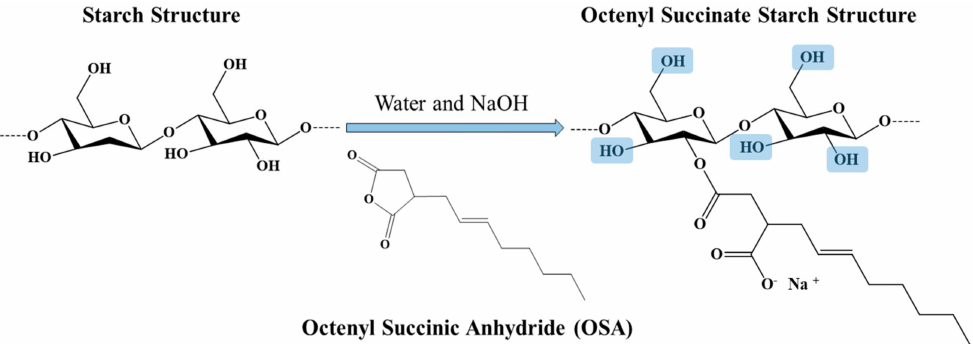
Figure 1. Schematic representation of the octenyl succinate starch obtention in alkaline conditions. Blue squares indicate the inclusion zone of the OSA groups. Adapted from Sweedman et al.